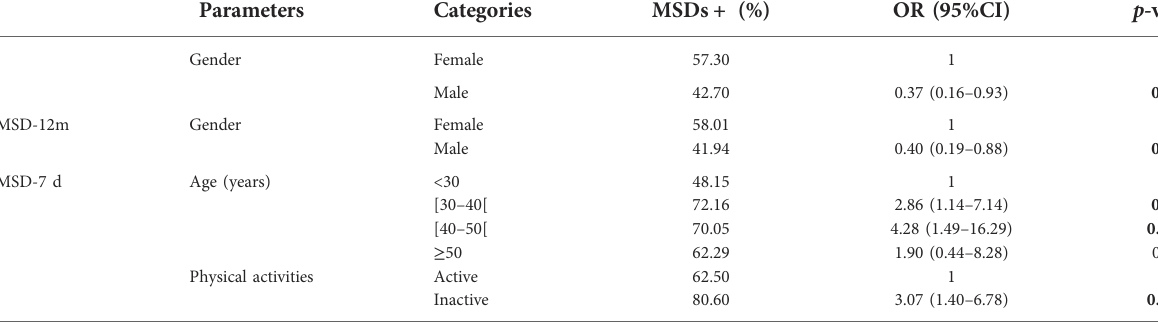
TABLE 2 Multivariate logistic analysis of associated factors with